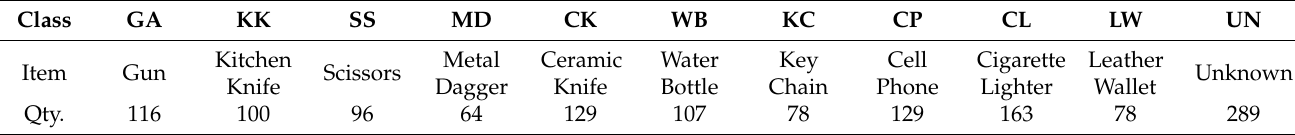
Figure 2. Visualization display of diversified data of terahertz object detection dataset. On the top of the figure are the data characteristics. Table 1. Object classes of terahertz object detection